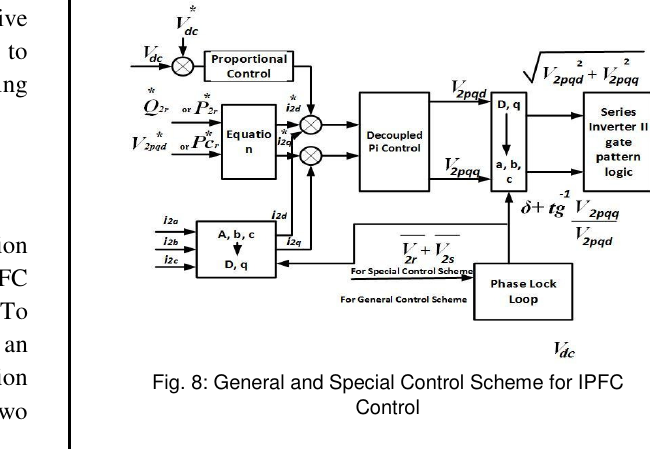
Fig. 8: General and Special Control Scheme for IPFC